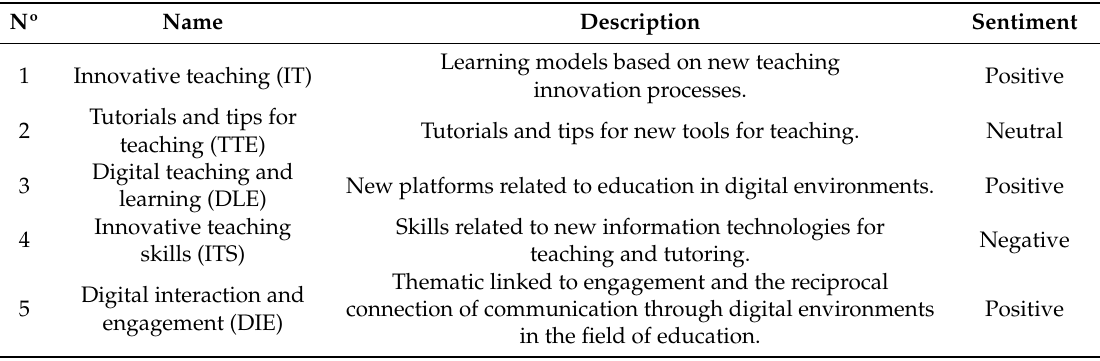
Table 1. Mean latent Dirichlet allocation (LDA) topics results description.